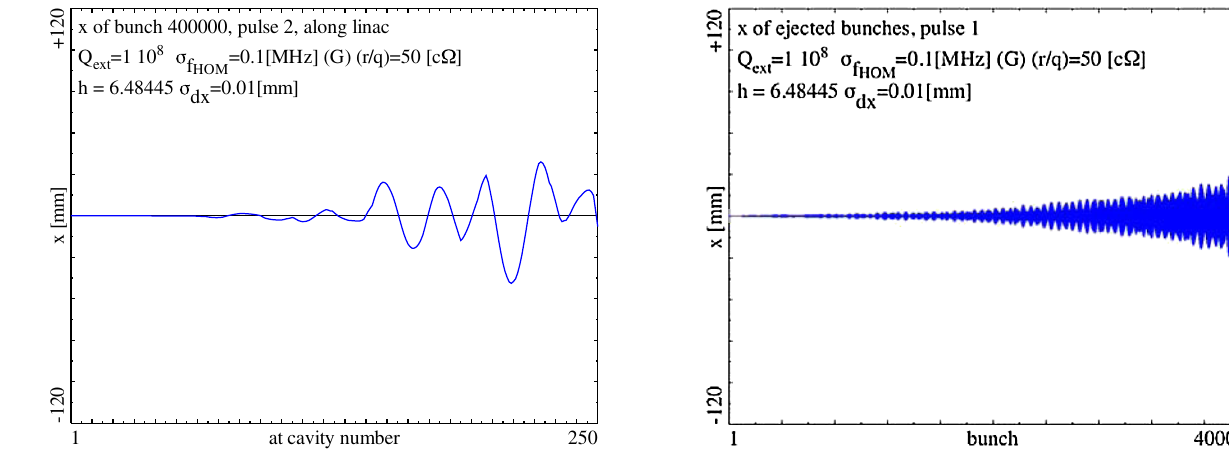
FIG. 56. (Color) x [mm] corresponding to Fig. 54 (1st pulse).